Question: Judging by this figure, is the value going up or going down?
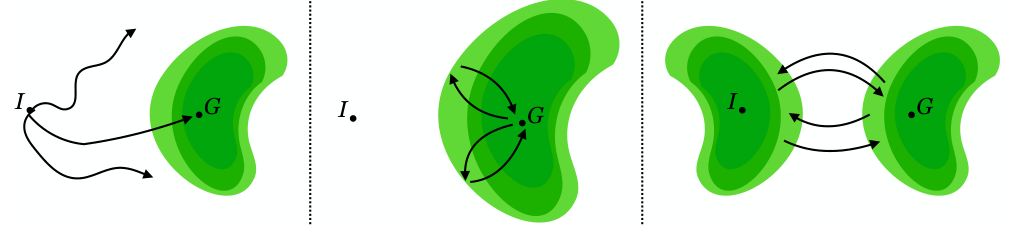
Answer: decreasing